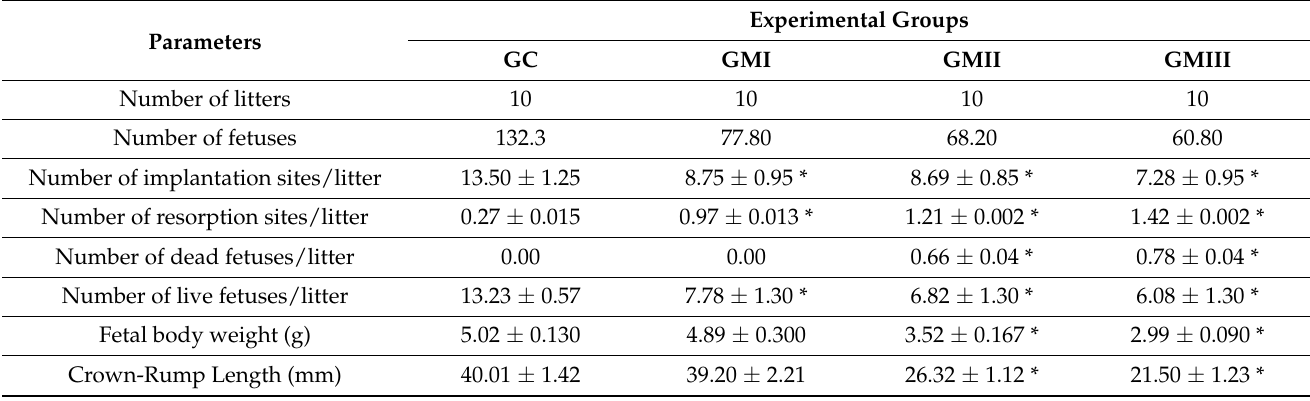
Table 1. Pregnancy outcomes of female rats treated with metronidazole at di ff erent gestation peri- ods and sacri fi ced on the 20th day of gestation.